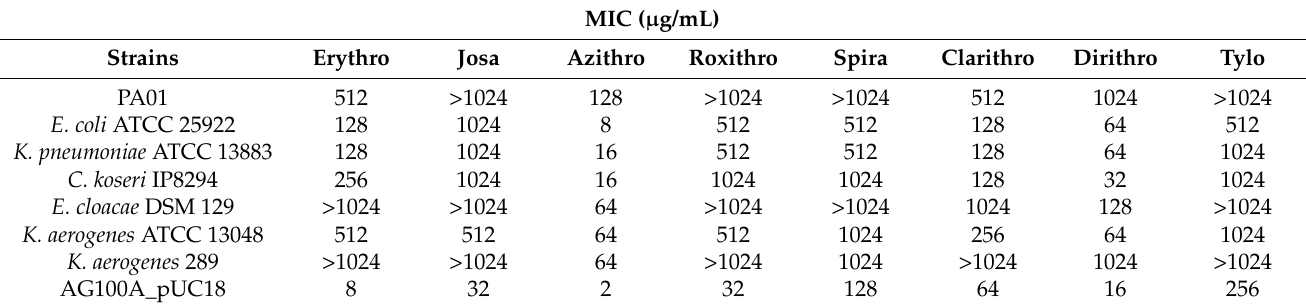
Table 3. Minimum Inhibitory Concentrations of macrolides against various Gram-negative